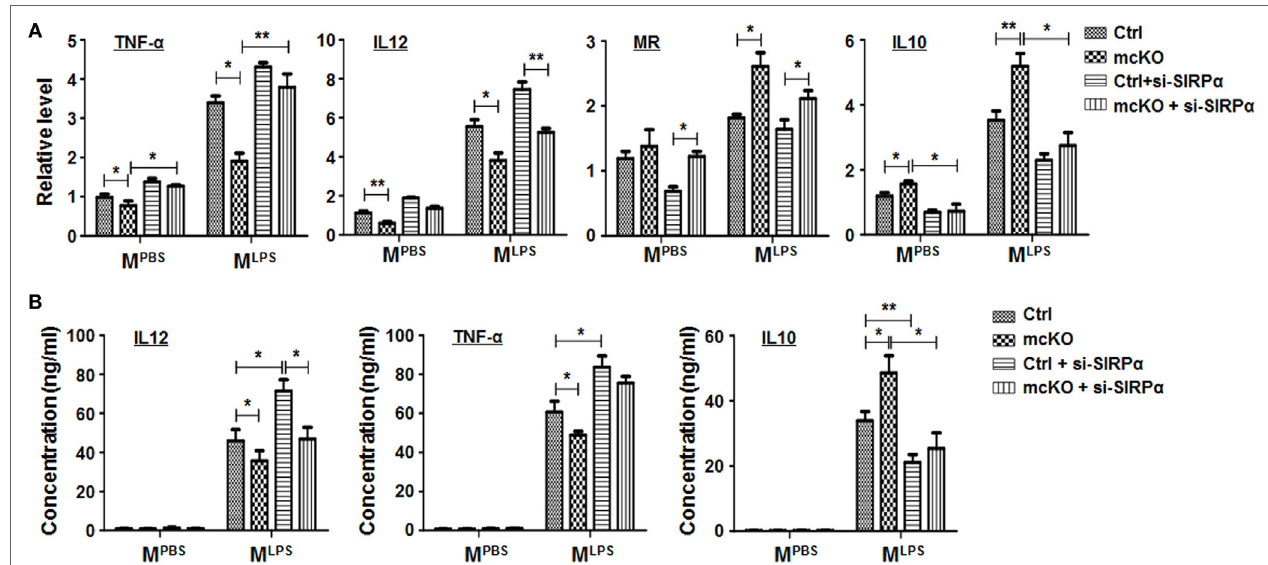
FigUre 4 | Notch signal regulated macrophage polarization partially through signal regulatory protein α (SIRP α ). (a,B) Bone marrow-derived macrophagess from RBP-J mcKO and control mice were transfected with siRNA for SIRP α and then cultured in the presence of PBS or lipopolysaccharide + interferon γ for 24 h. The expression of polarization markers (a) and the production of cytokines (B) were detected ( n = 4). One-way ANOVA test was used for statistical analyses. Bars represent means ± SD; * P < 0.05; ** P <